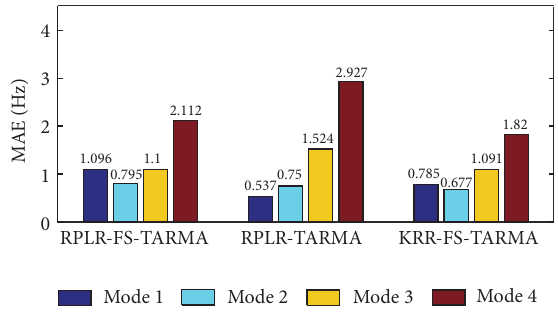
Figure 17: Monte Carlo comparison of different methods: MAE of natural frequency